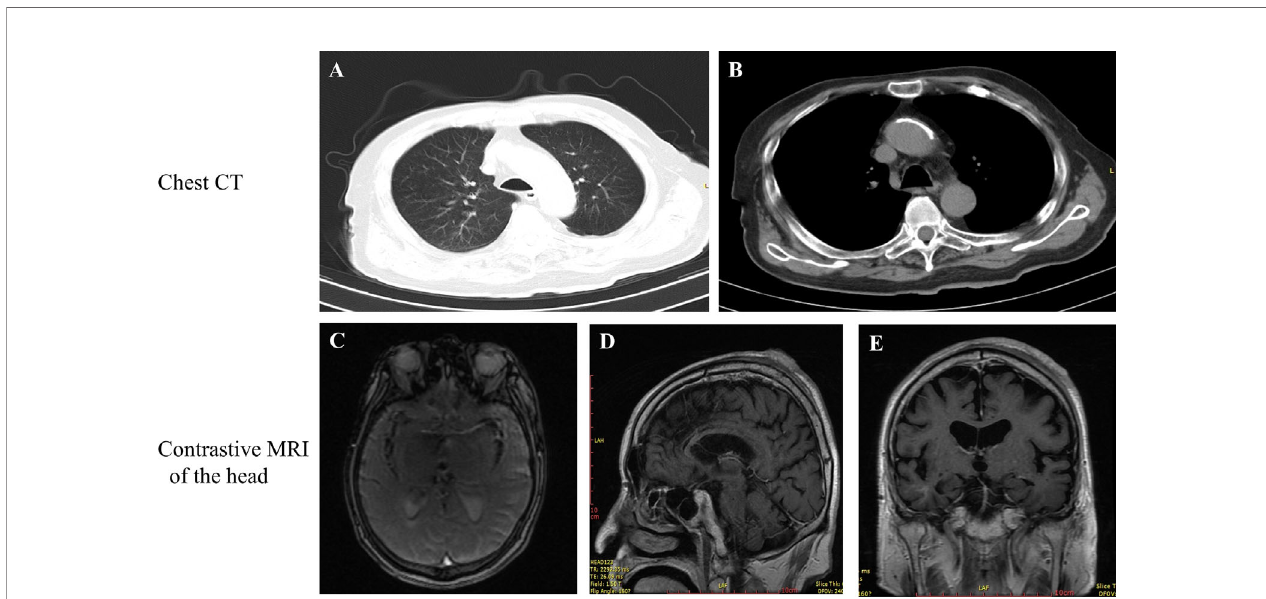
FIGURE 3 | (A, B) Examination of chest CT. (C) superior view, (D) lateral view and (E) posterior view of the scull during contrast MRI after 10 months treatment with